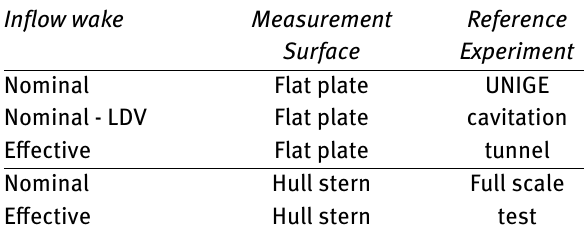
Table 3: Wake configurations analysed. Inflow wake Measurement